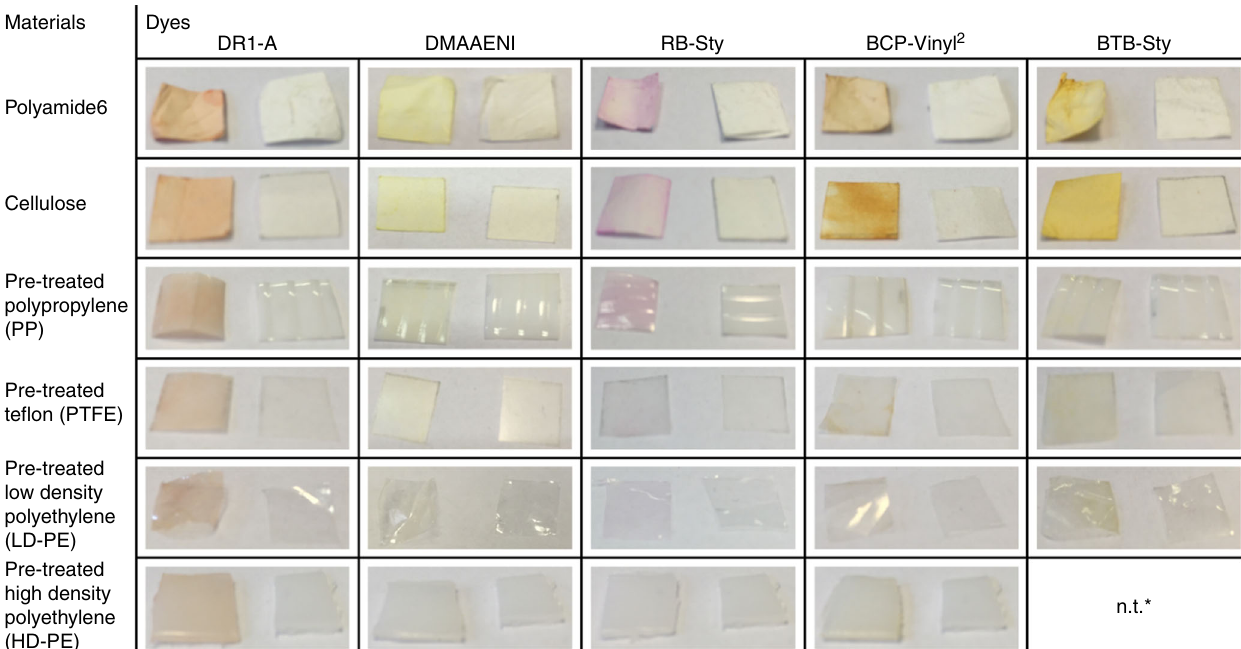
Fig. 6 Overview scheme of the treated materials and applied dyes using the optimized PDC procedure. Each picture of the treated material after puri fi cation is taken compared to an untreated reference sample of the used material; * not treated due to insuf fi cient amount of dye